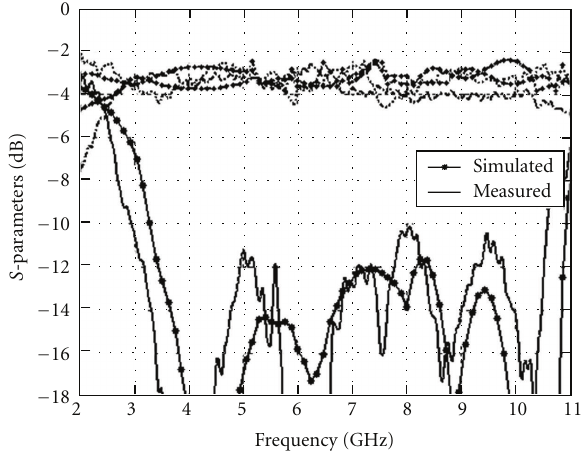
Figure 3: Simulated and measured Scattering S11 ( — ), S21 ( −· ), and S31 ( ··· ) parameters of the UWB Minkowski branch line coupler.